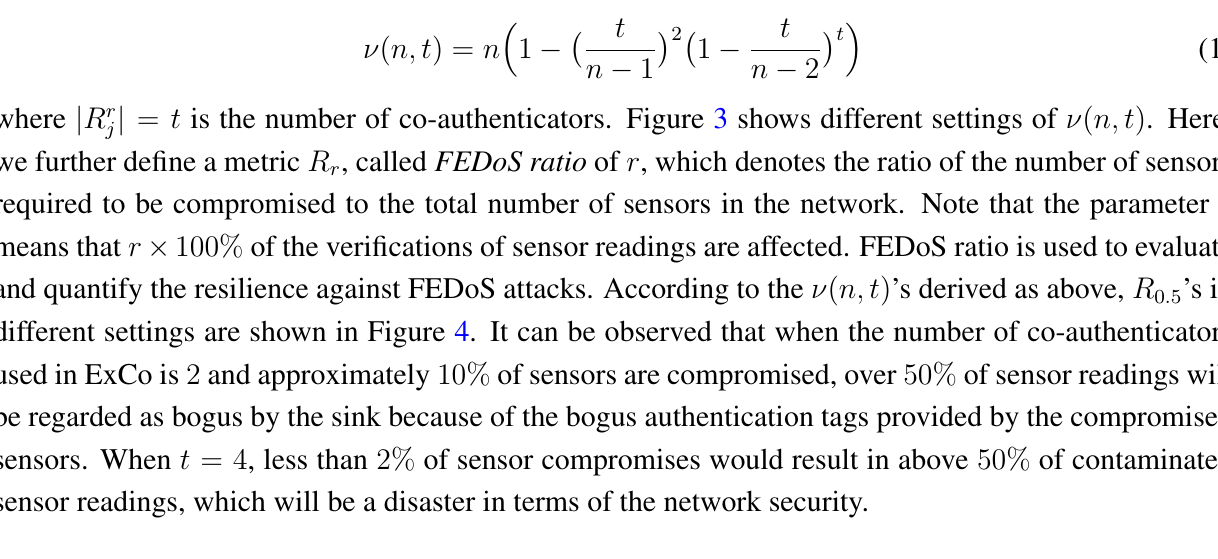
Figure 3. Expected number ν ( n, t ) of sensors involved in the authentication of the sensed data of one